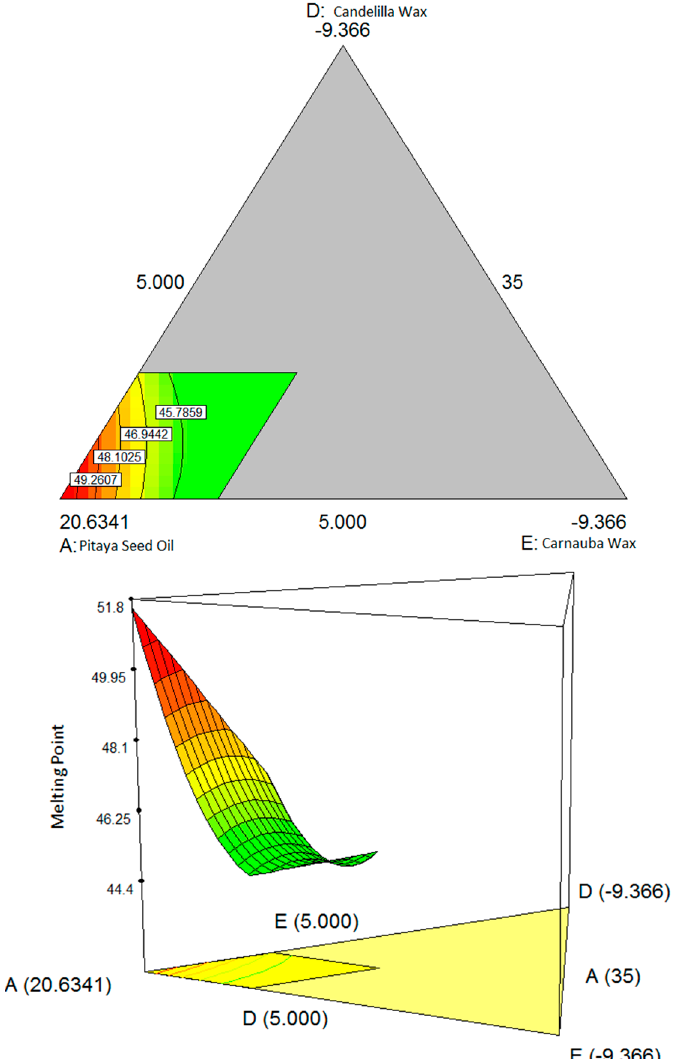
Figure 2. Contour plot (two-dimensional) and three-dimensional surface showing the interaction effect between three variables: ( A ) pitaya seed oil, ( D ) candelilla wax, ( E ) carnauba wax; and ( B ) virgin coconut oil and ( C ) beeswax are kept constant respect to melting